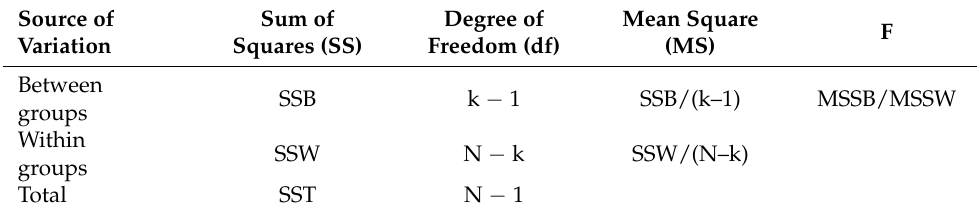
Table 1. ANOVA Table (Scofield,